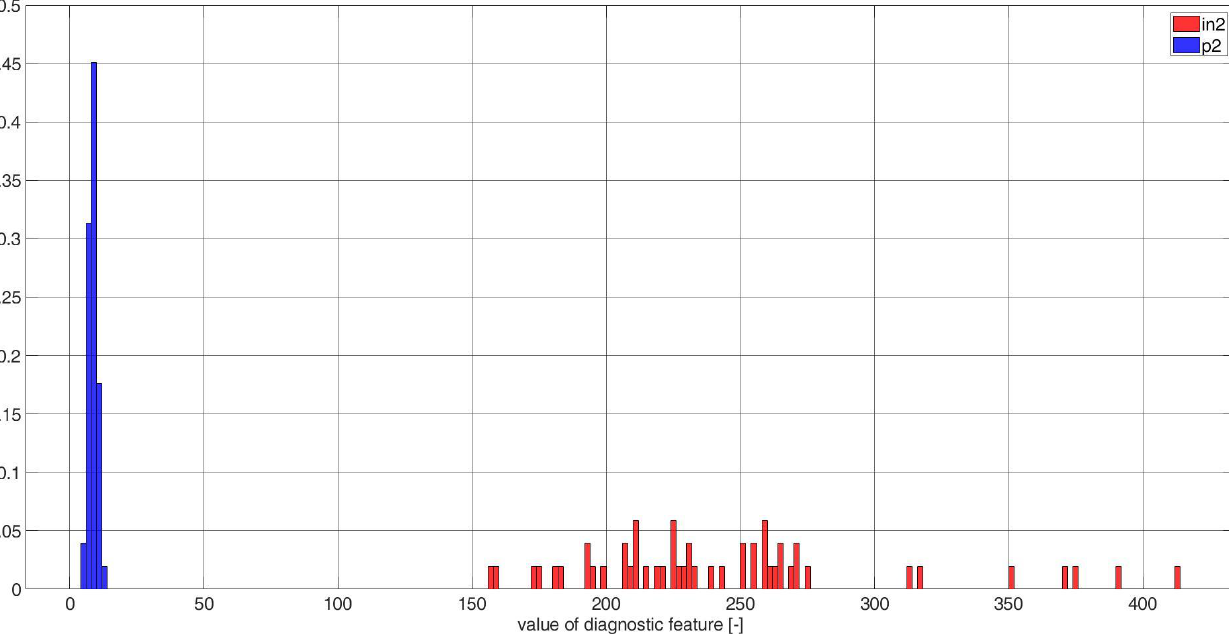
Figure A8. Histograms of diagnostic features based on the CCSM3 (correlation number is 7 — Table A1) bearings in2 and p2.